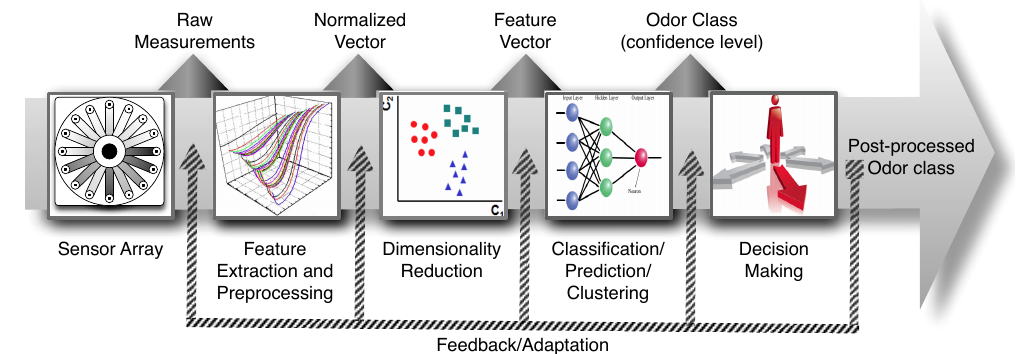
Figure 1. Stages of typical signal processing in an electronic